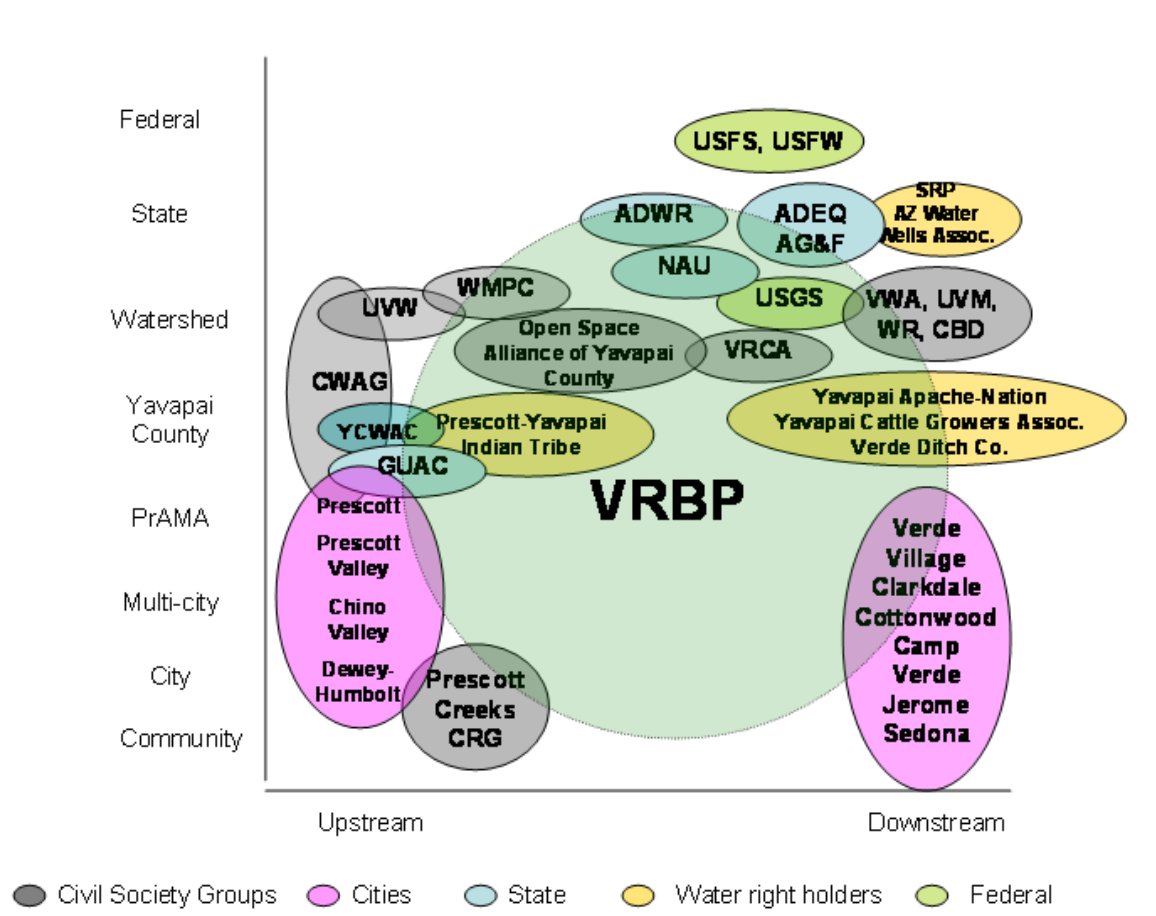
Fig. 2. . Conceptual model depicting the diverse set of political groups with interests in the Verde region and the Big Chino Water